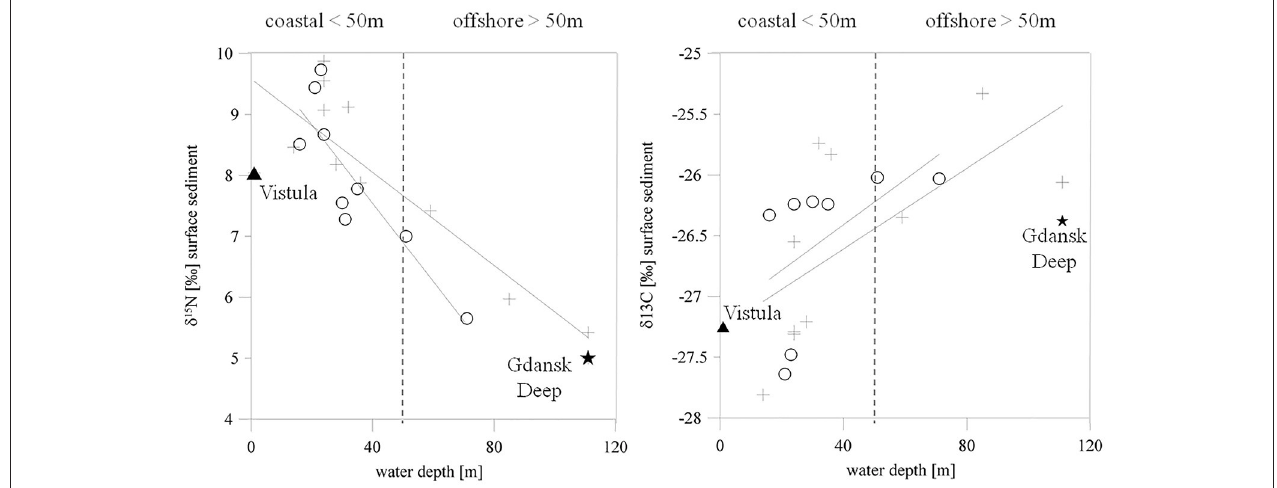
FIGURE 2 | δ 15 N (left) and δ 13 C (right) values of the organic matter from the upper surface sediments as a function of water depth. Crosses mark winter 2015 and circles spring 2016 data. The straight lines show the regression. The filled triangle represents Vistula River POM, and the filled star the surface-water POM at the deep-water station TF0233.